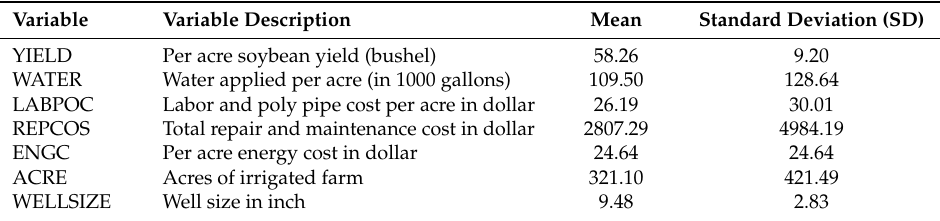
Table 1. Descriptive statistics of variables used in e ffi ciency analysis.